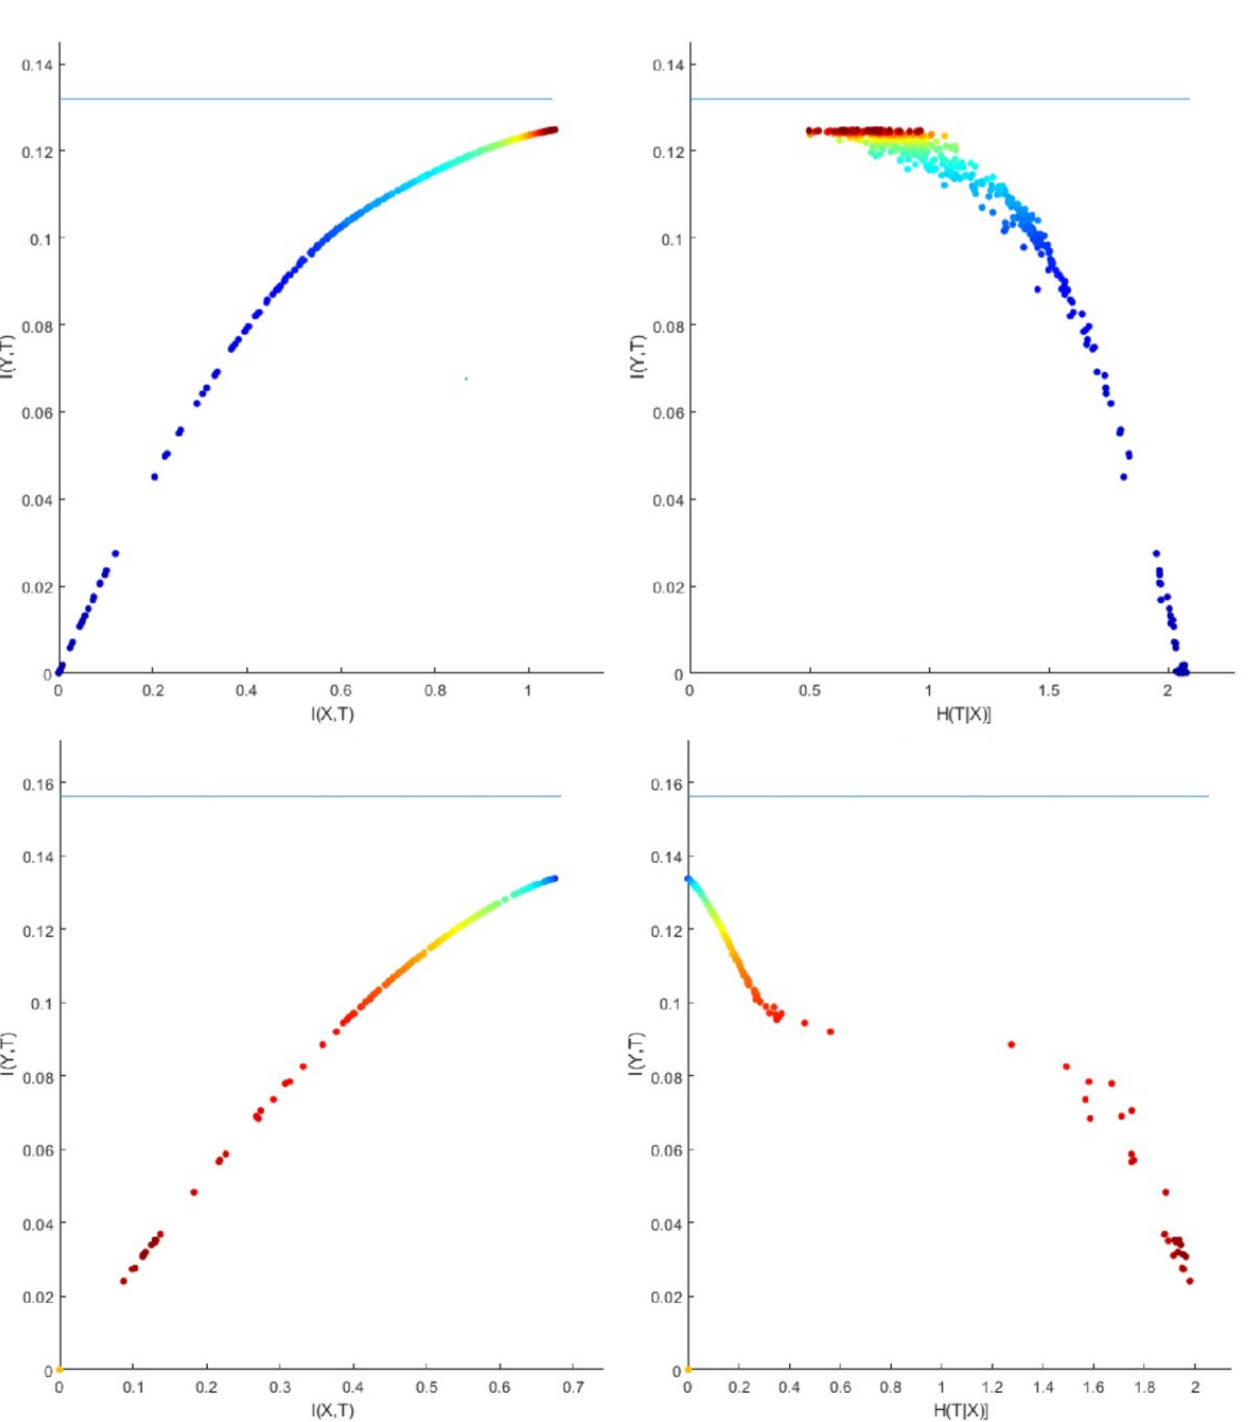
Figure A2. Top: α = 1; β takes 500 points evenly in [1.5, 51.5]; β from small to large corresponds to the colors started from blue to red. Bottom: β = 4.5; α takes 201 points evenly in [0, 1]; α from small to large corresponds to the colors starting from blue to red. The blue horizontal line is H(Y), which is the upper bound of